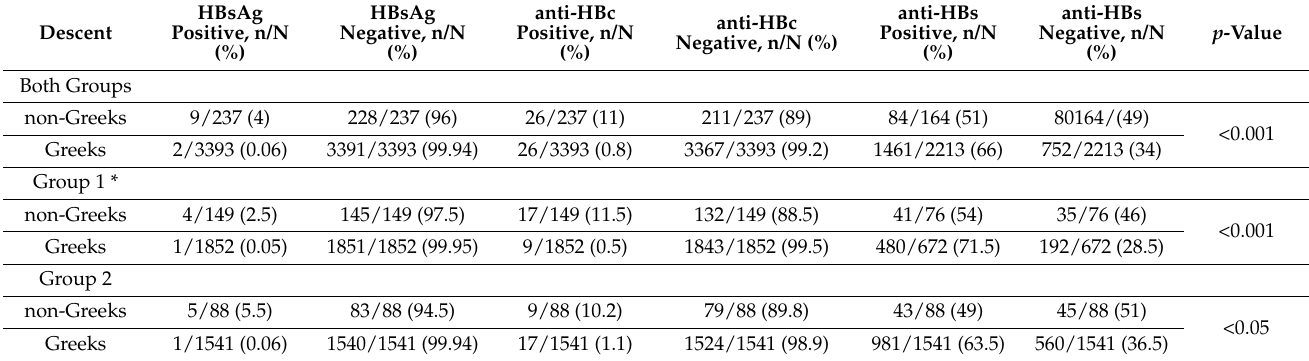
Table 3. Factors associated with HBsAg, anti-HBc and anti-HBs